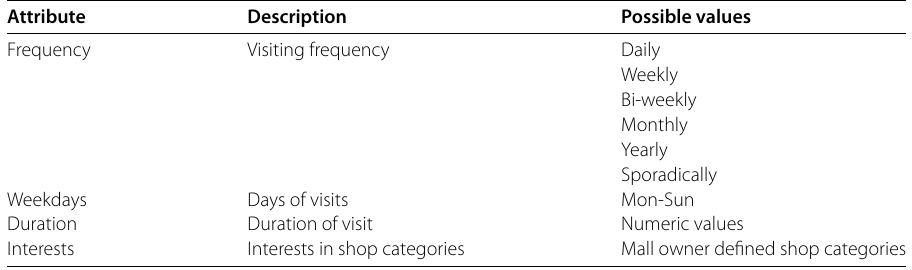
Table 3 Physical attributes of questionnaire data